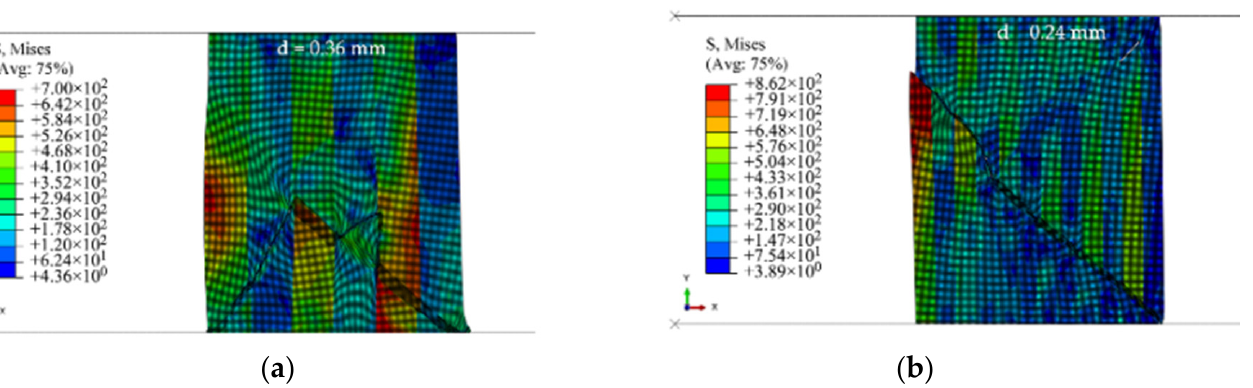
Figure 19. Sequence of crack initiation and growth in 3by3 and 18by18 models at 𝜀(cid:4662) (cid:3036) = 1 s − 1 : ( a ) for- mation of shear bands; ( b ), ( d ), ( e ) cracks form and grow in the layers of the brittle base material that are close to the outer wall; ( c ), ( f ) layers of the ductile material start to crack from the outer wall and connect the existing cracks in the brittle layers along the direction of shear bands. The stroke of top platen, d , is shown at the top of the models.